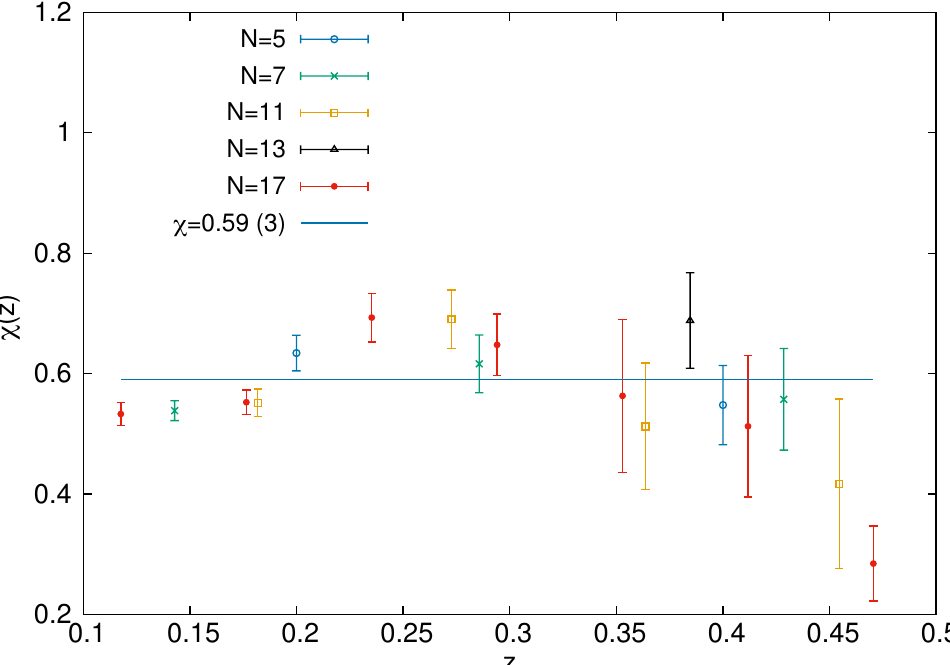
Figure 4. We display the value of the L(cid:127)uscher term function (cid:31) ( z ), appearing in eq. (3.4). The z dependence is extracted from (cid:12)tting various j ~n j = 1 torelon energies to eq. (3.6), allowing the p constant (cid:31) 0 to depend on z = ~ (cid:18)= (2 (cid:25) ) and setting (cid:27) 0 =(cid:21) = 0 :